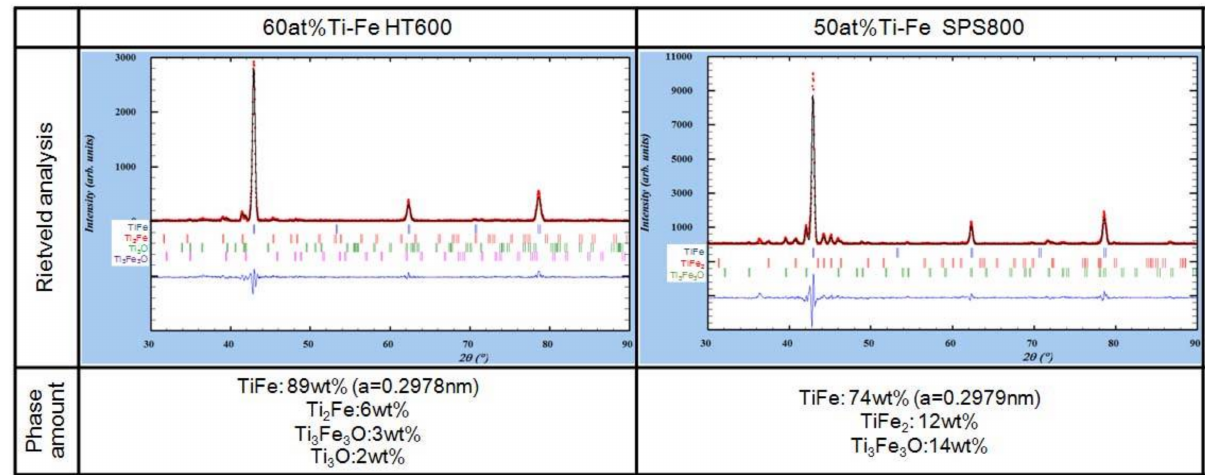
Figure 7. Rietveld analysis results for 3 h MA samples comparing annealing and SPS